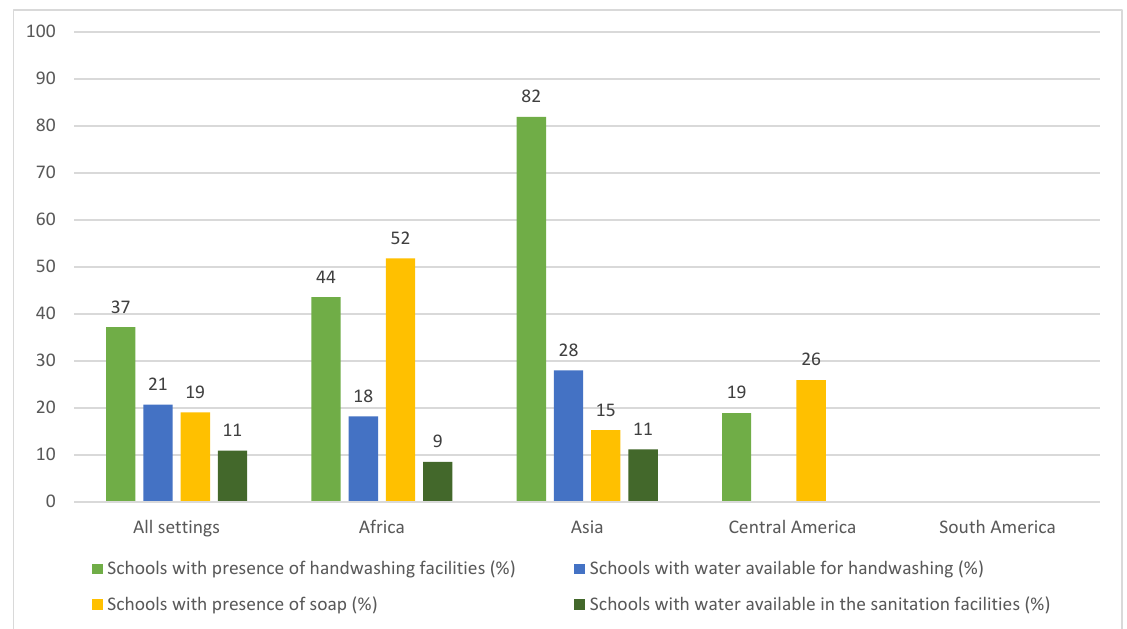
Figure 6. Percentage of schools with hygiene and related facilities according to the location of studies’ settings based on a review of the literature (n = 65 publications). * Number of schools in each setting assessed for handwashing facilities: Africa n = 2629; Asia n = 454; Central America n = 464; South America n = 0; All settings n = 6237. Number of schools in each setting assessed for water available for handwashing: Africa n = 2610; Asia n = 100; Central America = 0; South America n = 0; All settings n = 5400. Number of schools in each setting assessed for the presence of soap: Africa n = 671; Asia n = 1422; Central America n = 362; South America n = 0; All settings n = 5151. Number of schools in each setting assessed for water available in the sanitation facilities: Africa n = 105; Asia n = 775; Central America n = 0; South America n = 0; All settings n = 886. The total number of schools assessed is lower than the sum of schools per continent as some of the studies did not identify the schools per